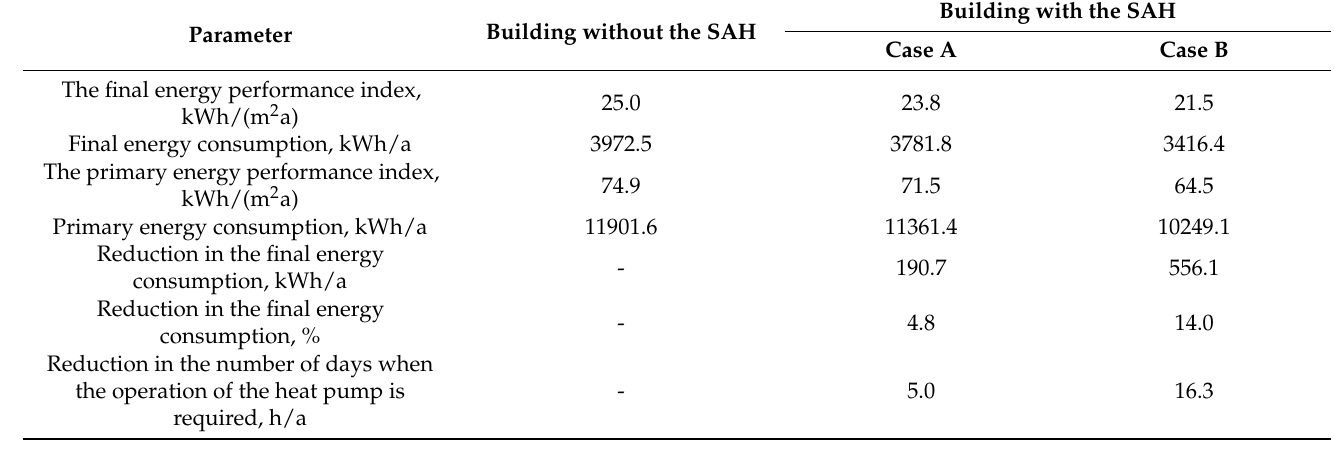
Table 10. The comparison of the final and primary energy consumption in the exemplary residential building without the SAH and with the SAH in the form of a solar chimney (Case A) or solar thermal wall (Case